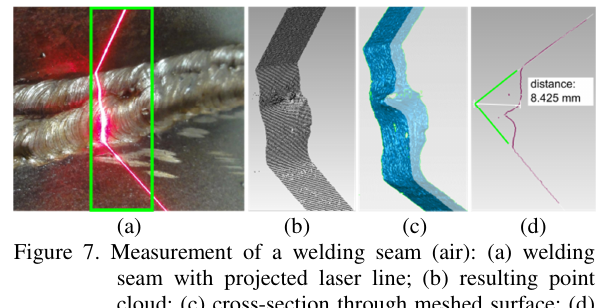
Figure 7. Measurement of a welding seam (air): (a) welding seam with projected laser line; (b) resulting point cloud; (c) cross-section through meshed surface;